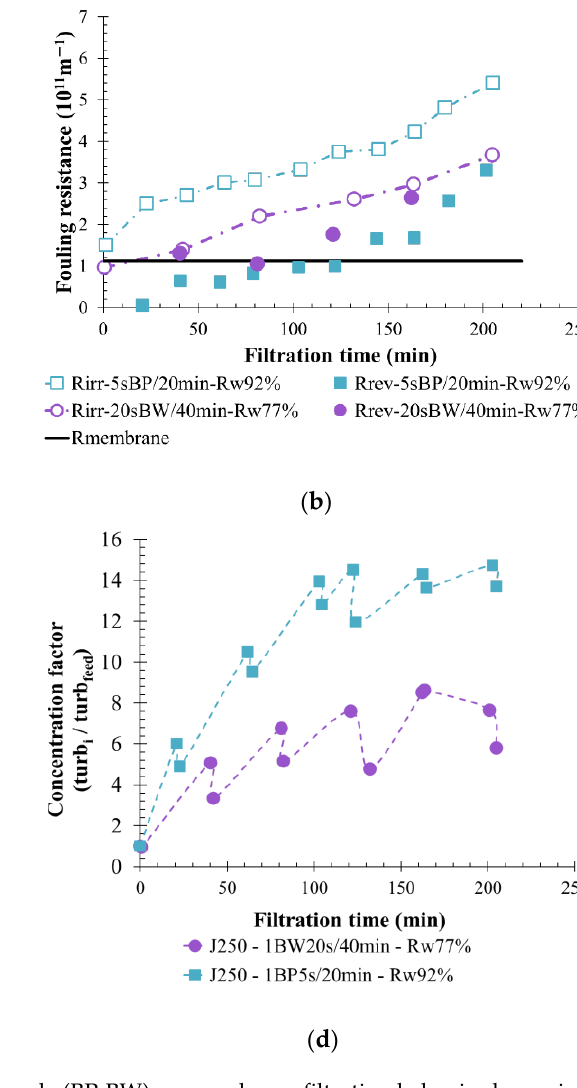
Figure 13. Influence of backflush mode (BP-BW) on membrane filtration behavior by variation of permeability at 20 °C ( a ); fouling resistance ( b ), the pressure ratio ( c ) and the turbidity concentration ( d ) throughout the time for a permeate flux of 250 L h −1 m −2 and a 1 BW 20 s/40 min (purple round) and 1 BP 5/20 min (blue squared). T = 20 °C, feedwater from APL-VANDA-AE; SiC membrane 0.33 m 2 . Jxx is permeate flux at the xx value in L h −1 m −2 ; 1BW yy s/zz min where yy is the duration and zz the interval of filtration between two BF; and Rw is the total recovery rate applied on the unit; R irr is irreversible resistance; R rev is reversible resistance and R membrane is the membrane resistance, turb i is the turbidity of the sample, turb feed is the turbidity of the feed water. Water coming from S-AE was considered as a medium-fouling water. Permeability during its filtration varied between 1200 and 200 L h −1 m −2 bar −1 (Figure 2c). BF operating conditions were studied with a permeate flow of 150 L h −1 m −2 and continually produced